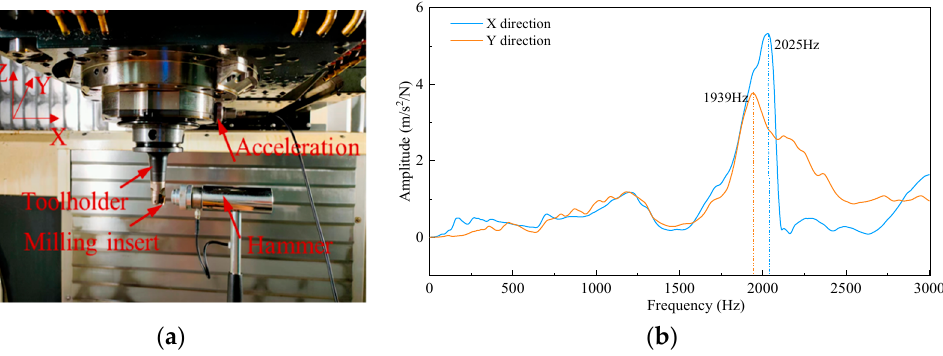
Figure 7. Modal test and frequency response function. ( a ) Modal test; ( b ) Frequency response function of machining system.